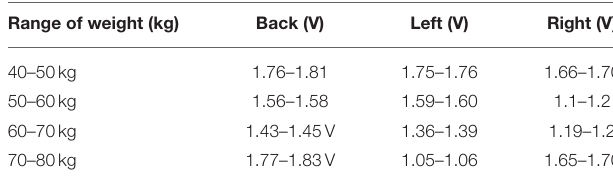
Frontiers in Digital Health |